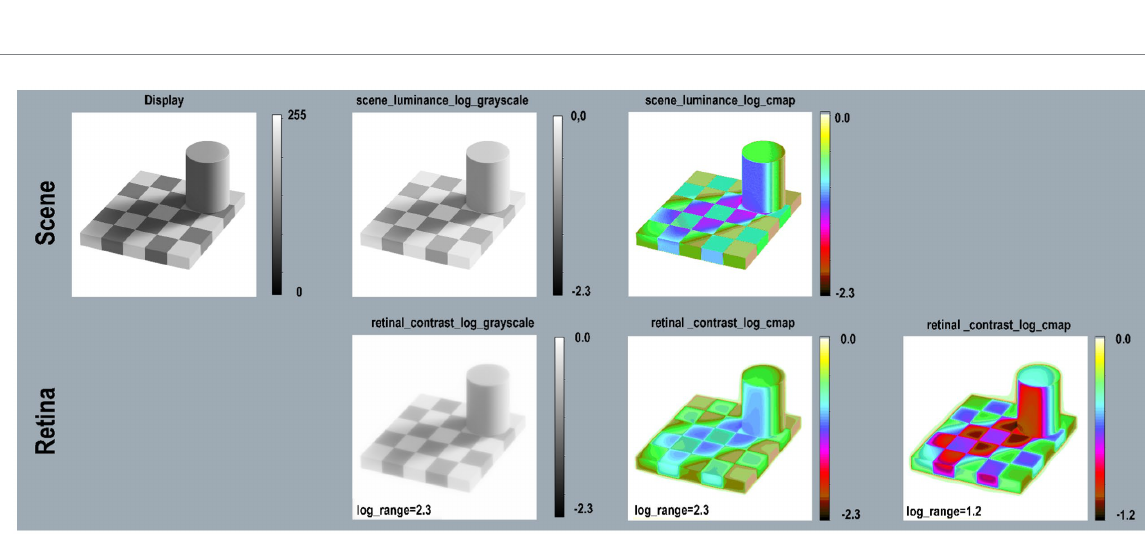
Multi-resolution edge-detection techniques (Frankle and McCann, 1983; McCann and Rizzi, 2011) are needed to address Glare’s Paradox.